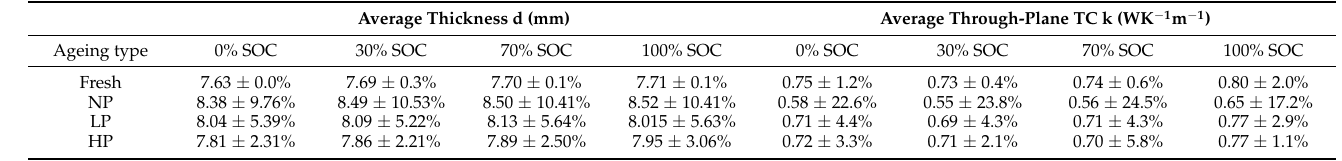
Table 2. Average thickness and average through-plane thermal conductivity values for fresh and aged cells.